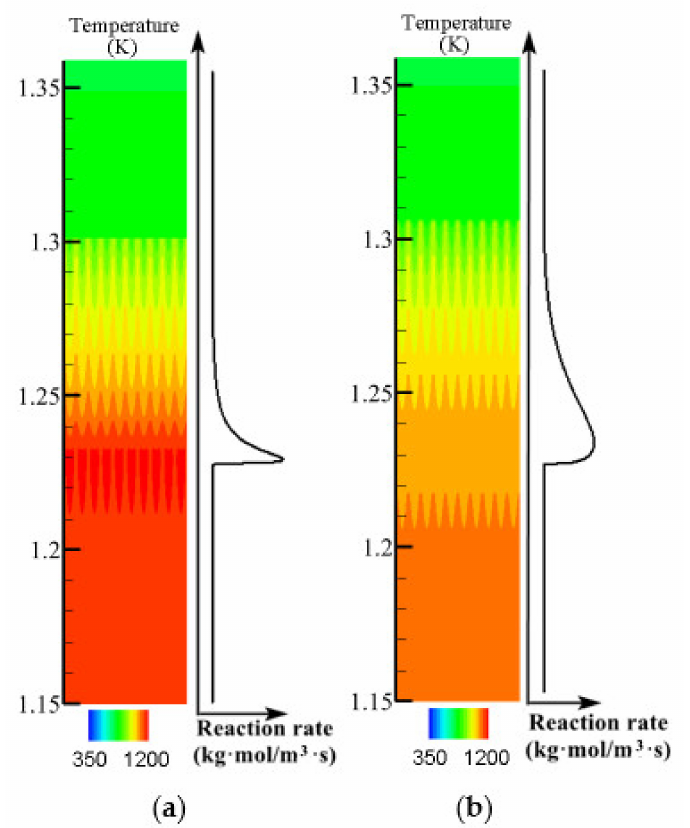
Figure 15. Comparison of temperature field in the reaction zone with an inlet flow rate of 700 m 3 /h,